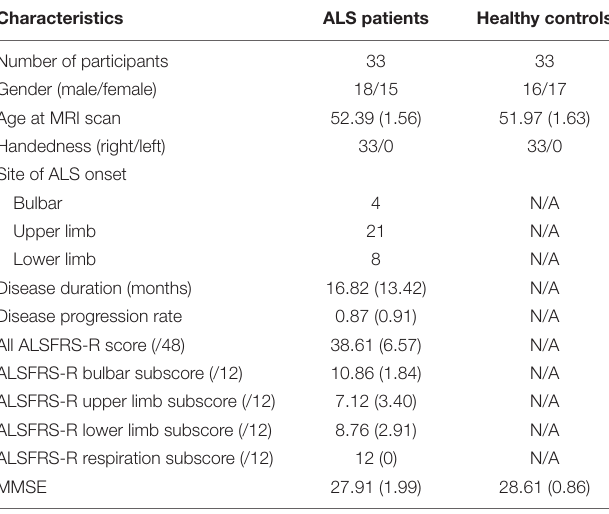
TABLE 1 | Demographic characteristics of the cohorts.